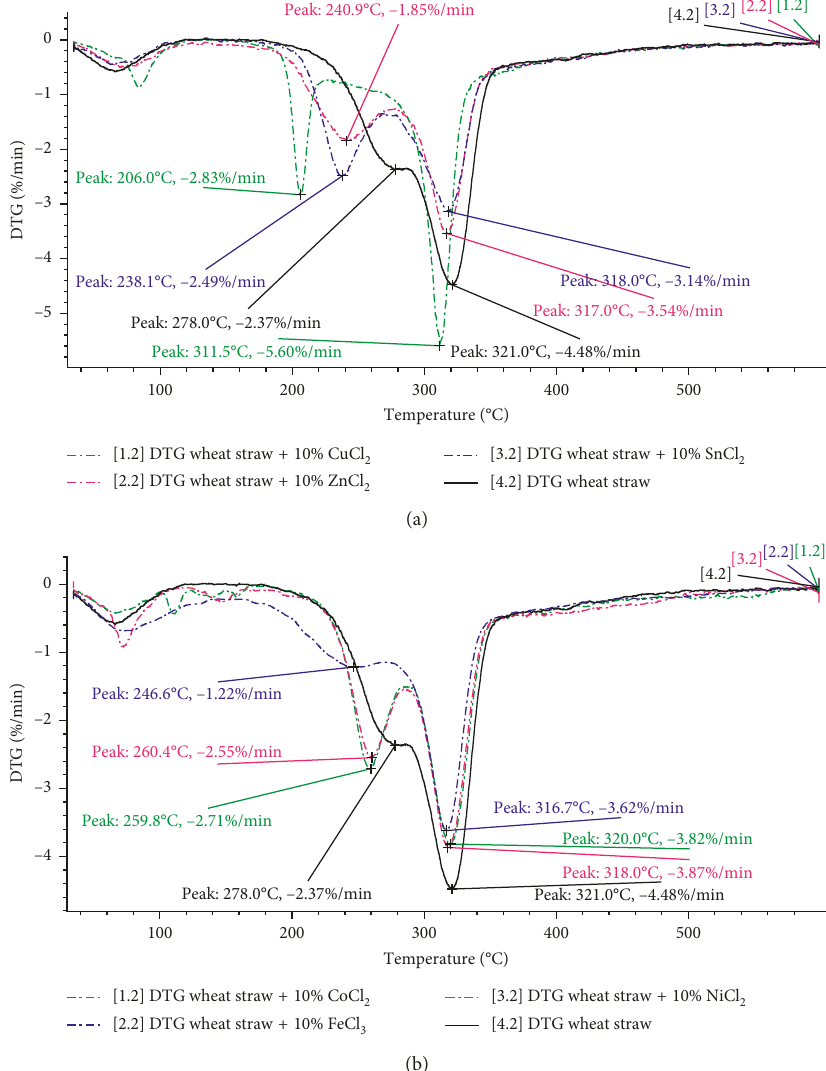
Figure 4: DTG curves obtained as a result of pyrolysis of wheat straw in the presence of copper, tin, and zinc chlorides (a); iron, cobalt, and nickel chlorides (b); and a sample of straw without